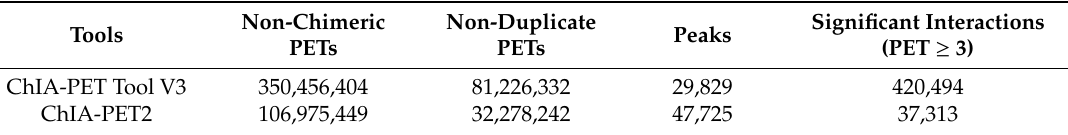
Table 9. Statistics of di ff erent tools from human GM12878 cells.